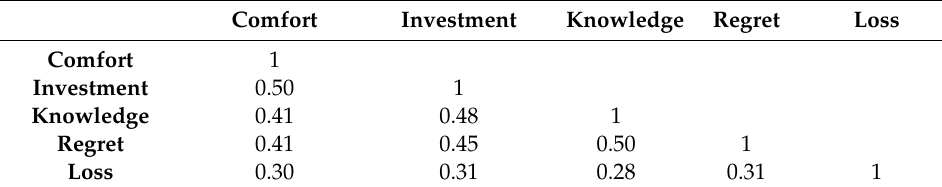
Table 3. Correlation among di ff erent dimensions of the FRA. Comfort Investment Knowledge Regret Loss Comfort 1 Investment 0.50